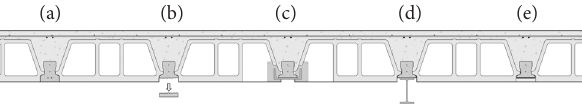
Figure 2: Constructive detail (a) healthy joist, (b) joist with severe corrosion and spalling, (c) joist repaired with UPN profile, (d) joist repaired with IPE profile, and (e) joist repaired with CFRP